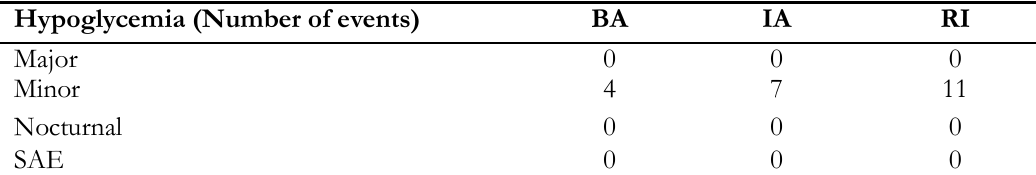
Table IV. Number of ADRs observed among diabetic patients Hypoglycemia (Number of events)